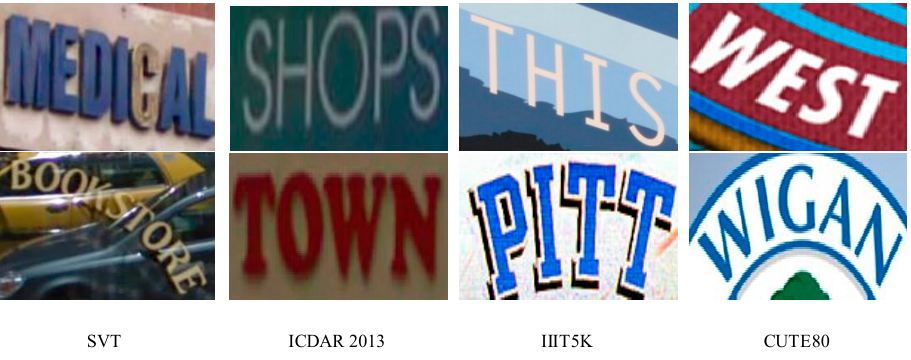
Figure 7. Sample of the scene texts in the data sets in this paper.